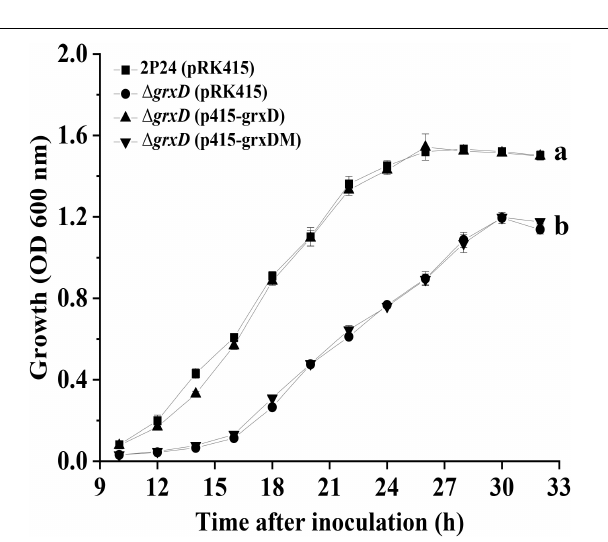
FIGURE 4 | The effect of grxD gene on the growth of Pseudomonas fluorescens . Strain 2P24 and its derivatives were cultured in ABM medium and the absorbance at 600 nm were measured at different points of the growth curve. All experiments were performed in triplicate, and different letters indicate a significant difference at the 0.05